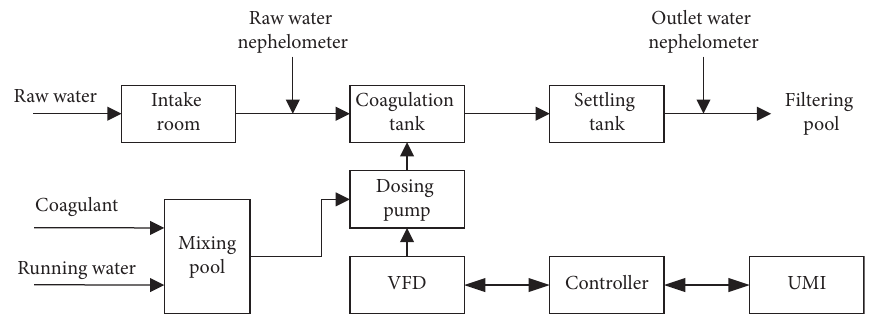
Figure 1: Schematic diagram of coagulation